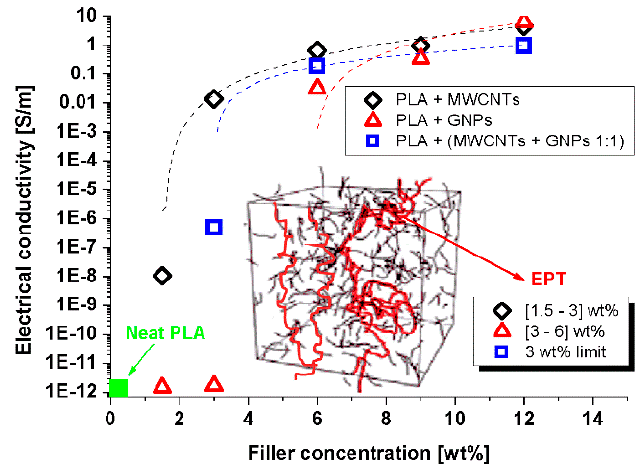
Figure 9. Electrical conductivity versus the filler content (wt %) for the different systems. In the inset, a schematic representation of electric percolation thresholds (EPT) and the values achieved in the present study. Figure 8. Thermal conductivity of carbon nanotubes (CNT)/PLA, GNP/PLA and (CNT + GNP 1:1)/PLA composites, as varying the filler contents. Markers represent experimental data, whereas lines are the interpolation curves. Table 3. DC electrical conductivity (S/m]. Table 2. Thermal conductivity (W/mK). Filler